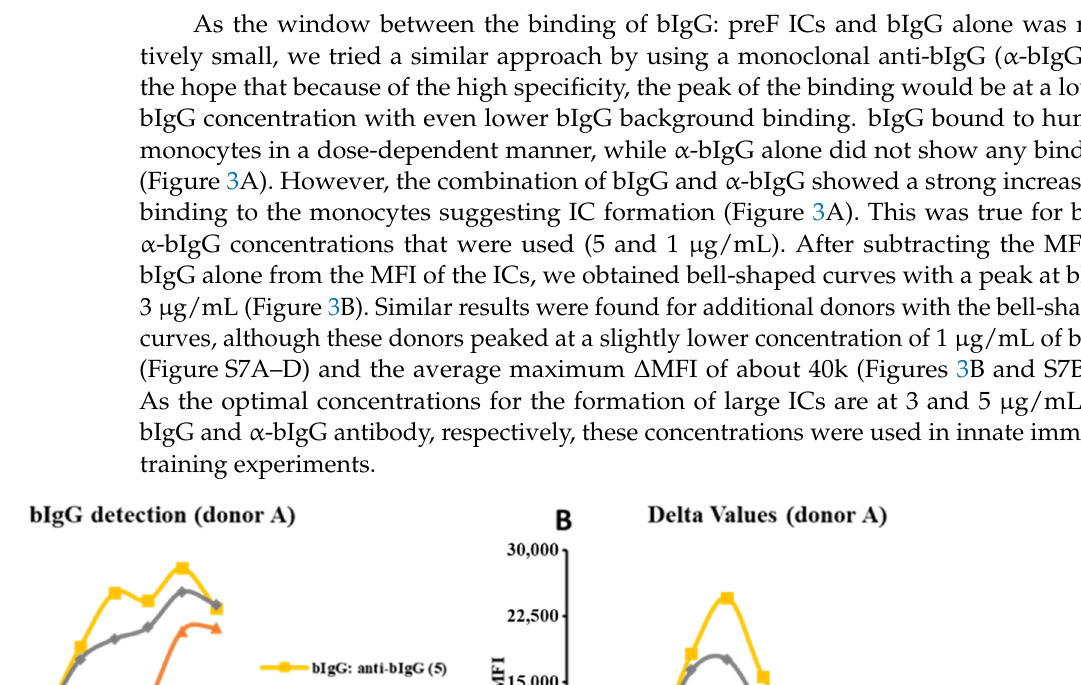
Figure 2. The curves drawn from MFI of the bIgG detection signal: CD14 + monocytes were exposed to bIgG only (0–100 µ g/mL), preF protein only (50 µ g/mL), and the bIgG: preF ICs in one representative donor (donor A); the MFI was used to generate the detection curve ( A ). The delta MFI ( ∆ MFI) was produced when the MFI of the bIgG only signal was deducted from the MFI of the bIgG: preF ICs signal ( B ).